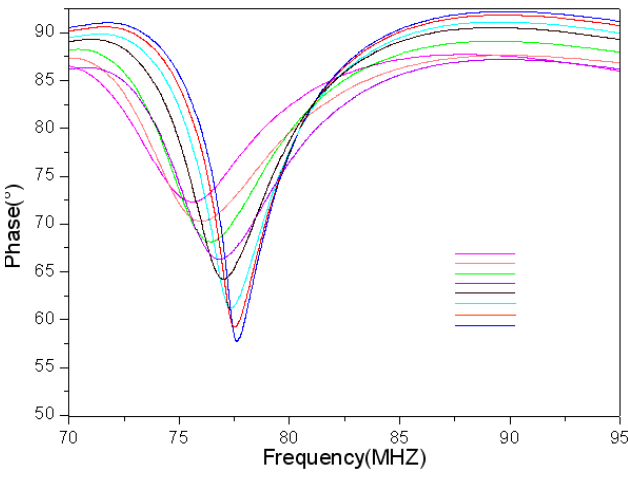
Figure 14. Measured impedance phase versus sensor frequency from 25 °C to 600